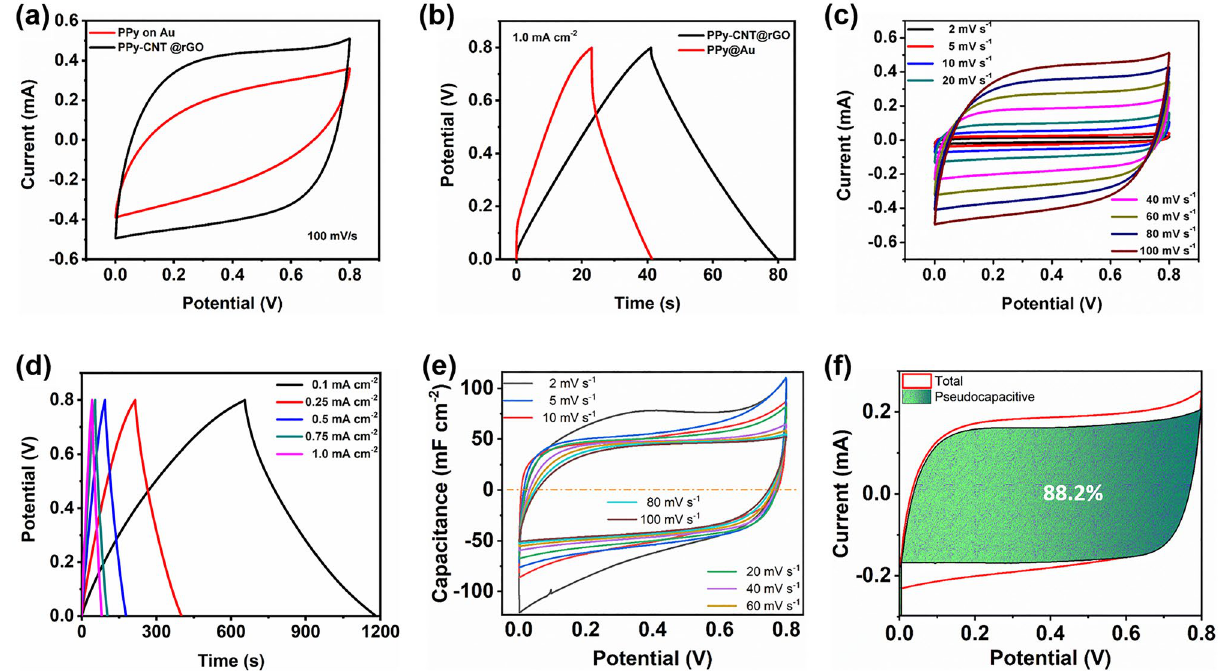
Fig. 4 a CV curves of PPy-CNT@rGO and PPy@Au MSCs at a scan rate of 100 mV s −1 . b GCD curves of PPy-CNT@rGO and PPy@Au MSCs at a current density of 1 mA cm −2 . c CV curves of PPy-CNT@rGO MSC at different scan rates from 2 to 100 mV s −1 . d GCD curves of PPy-CNT@rGO MSC at different current densities from 0.1 to 1.0 mA cm −2 . e Areal capacitance at different scan rates with the potential range from 0 to 0.8 V. f Capacitance separation analysis of PPy-CNT@rGO MSC at a scan rate of 5 mV s